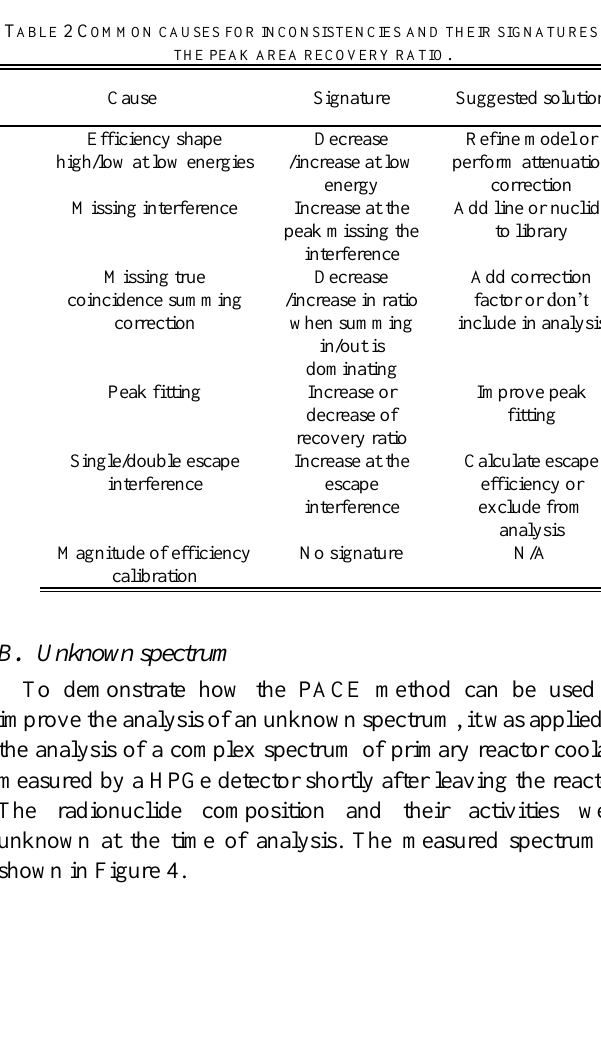
listed in Table 3. For one of the peaks, peak fitting